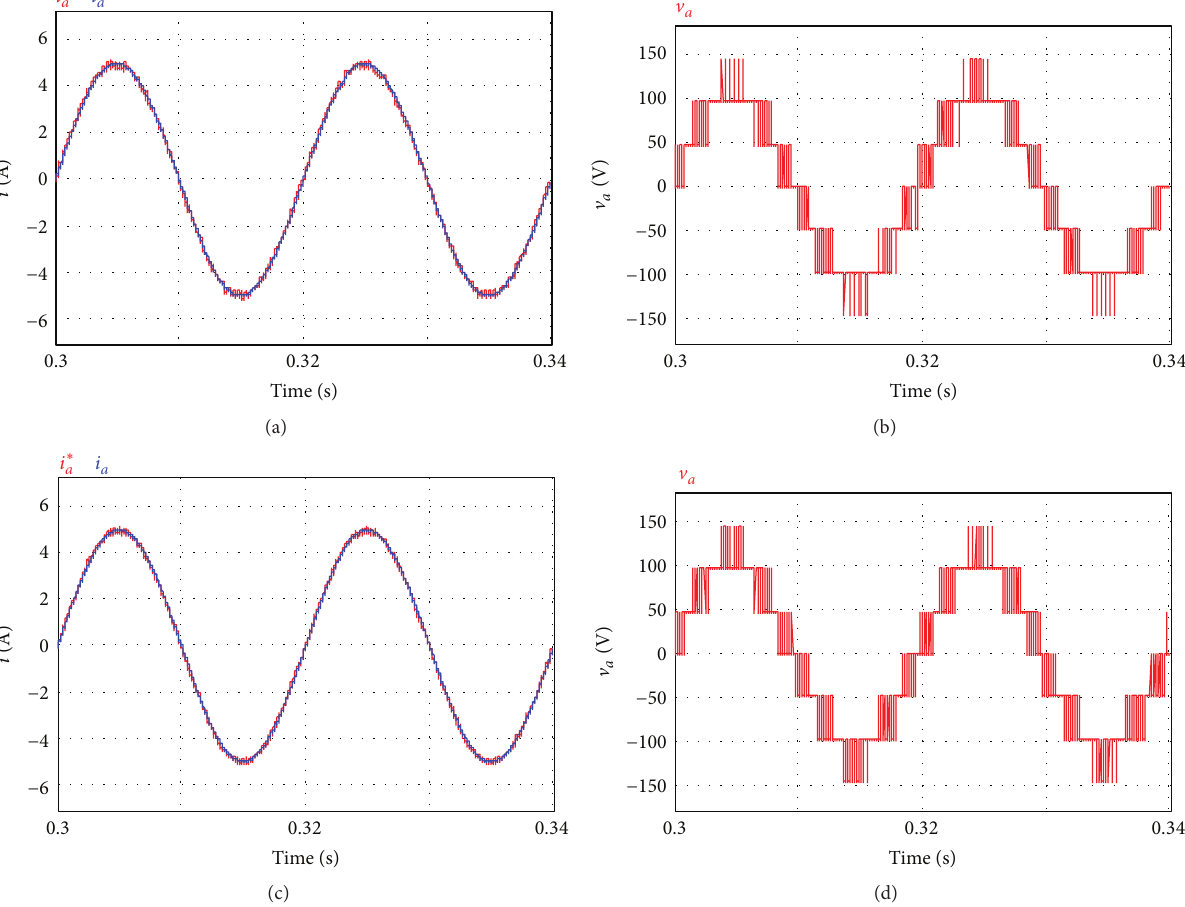
Figure 5: Simulation results in steady state: (a) Grid-connected current and reference current with conventional FS-MPC. (b) Output voltage with conventional FS-MPC. (c) Grid-connected current and reference current with simplified FS-MPC. (d) Output voltage with simplified FS-MPC.